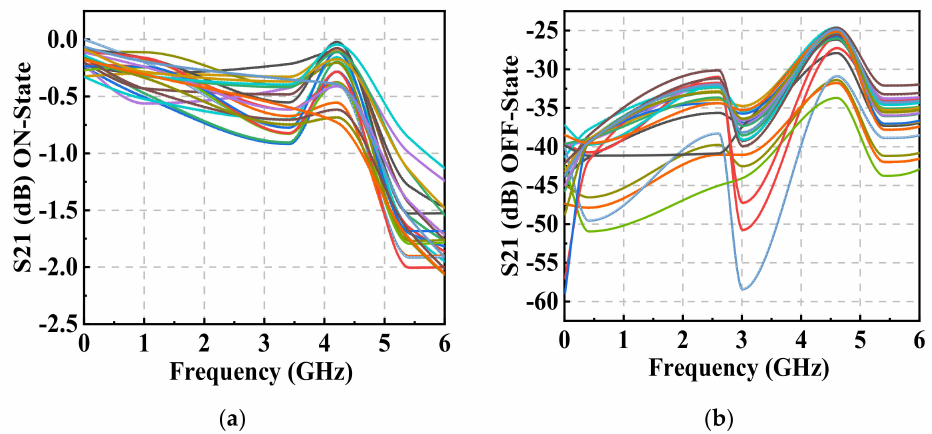
Figure 12. ( a ) The insertion loss of the switch in different channels; ( b ) The isolation of the switch in different channels. There is a variation due to bonding wire